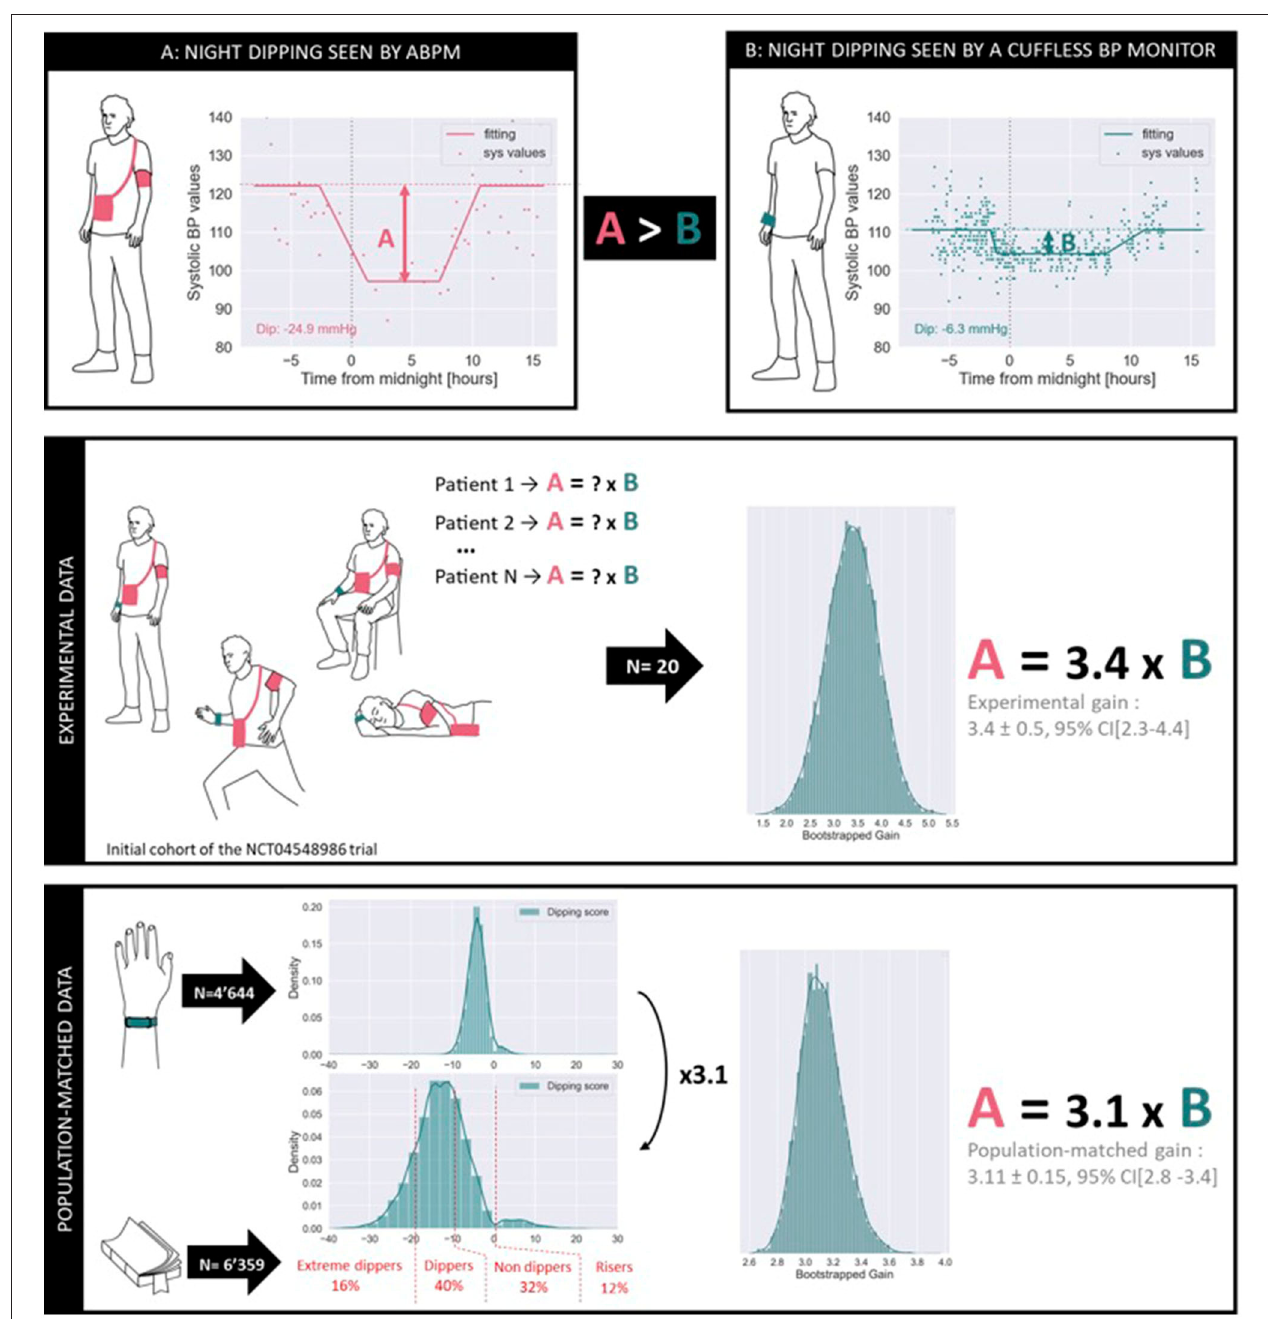
FIGURE 7 | Comparison of the estimation of nocturnal dipping as measured by ABPM and by a continual cuffless BP monitor. The upper panel illustrates differences in estimated SBP dips on a patient of the NCT04548986 trial. The middle panel demonstrates a systematic factor of 3.4 across the initial cohort of patients of the same trial. The lower panel demonstrates a systematic factor of 3.1 across N = 4,644 users of the same commercial cuffless BP monitor when matching the phenotype distributions to that of a large independent trial ( N = 6,359). As expected, different monitoring modalities tend to provide similar phenotyping information but require the application of technology-dependent conversion